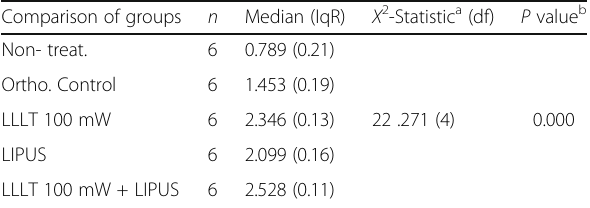
Table 4 Comparison of median of RANK gene expression levels among the study groups at day 21 Comparison of groups